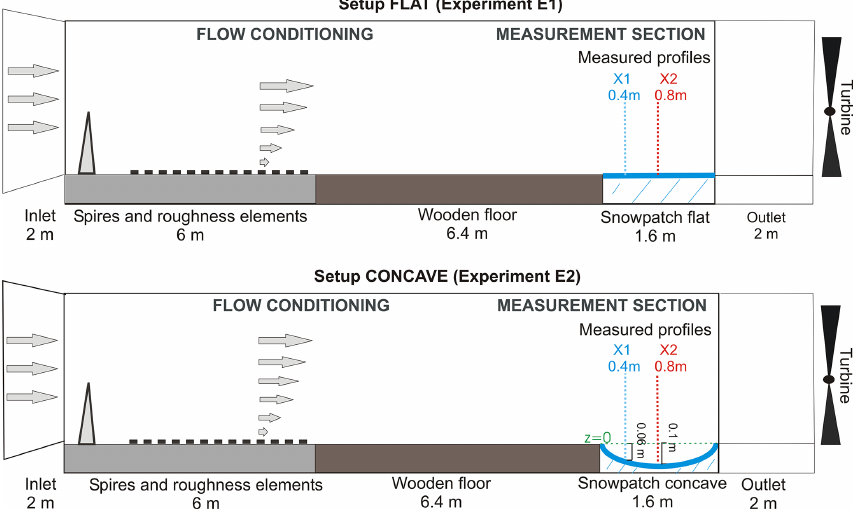
Figure 1. Sketch of the SLF boundary-layer wind tunnel and measurement setup of experiment 1 (flat setup, E1) and experiment 2 (concave setup, E2). Measurement positions X are given relative to the leading edge of the snow patch, with X0 = − 0 . 1m, X1 = 0 . 4m, and X2 = 0 . 8m. Note that all heights z used in the following figures are relative to the height of the topographical step z = 0. Consequently for the concave setup, the local surface at X1 corresponds to z = − 0 . 06m and at X2 to z = − 0 .